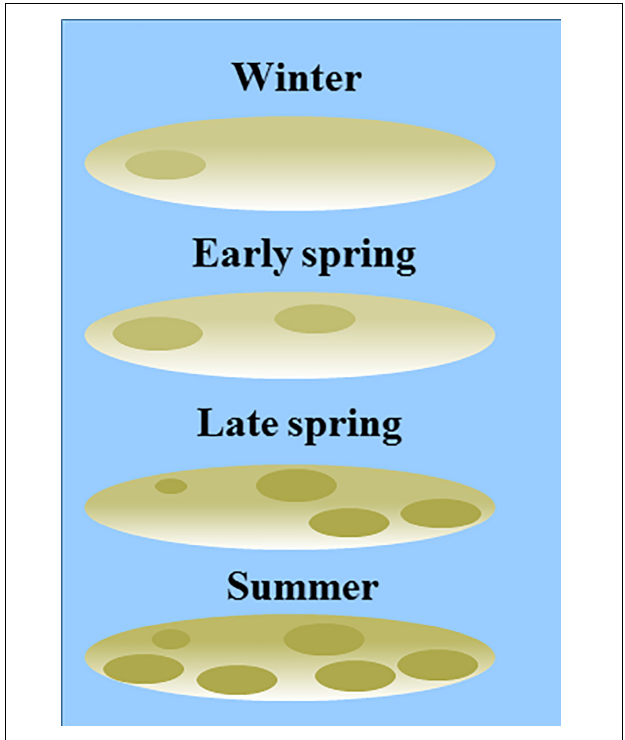
FIGURE 8 | Conceptual model of seasonality in patch size (based on the range derived from a semi-variogram) and degree of patchiness (sill derived from a semi-variogram) in MPB biomass, complemented by visual observations of the sites. No boundary values for areas of ‘MPB patches’ versus ‘bare sediment’ were used in the current